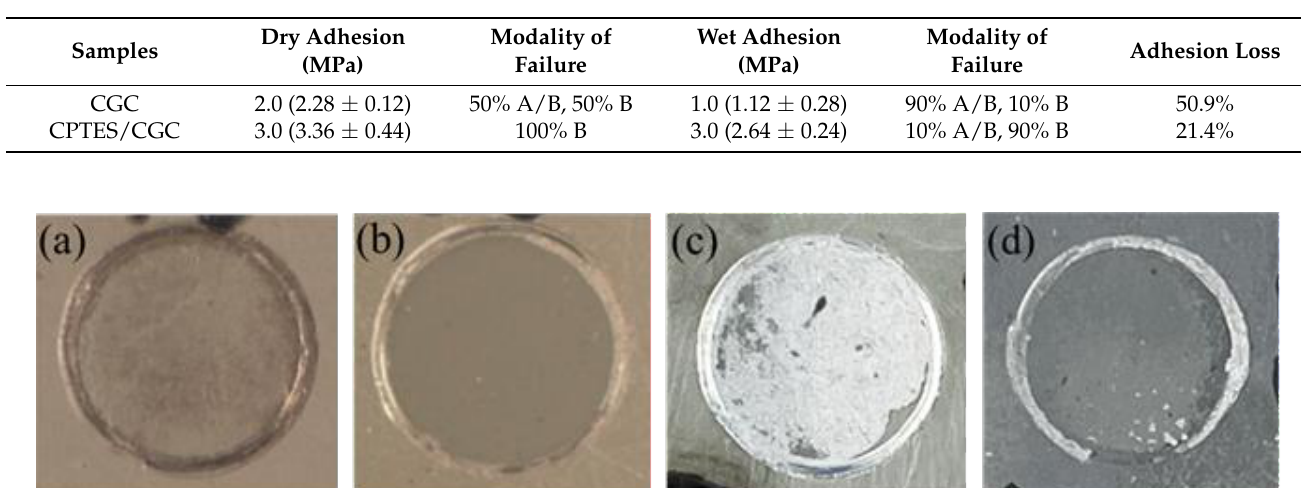
Table 3. Dry and wet adhesion strength of CGC and CPTES/CGC.